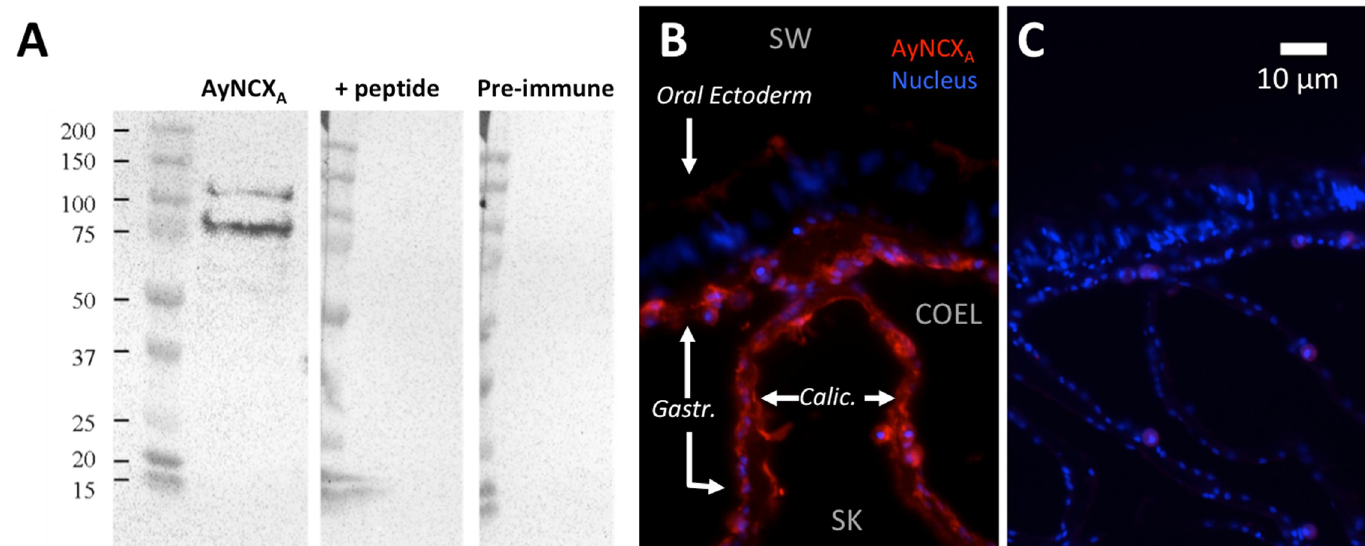
Fig 3. Validation of antibodies against AyNCXA. A) The anti-AyNCX A antibodies recognize a ~100 kDa and ~75 kDa protein in homogenized A . yongei tissue. Both bands are eliminated when the antibody is pre-absorbed with the epitope peptide overnight, and neither band is present when the membrane is incubated with the pre- immune serum. All sample wells contain the same amount of protein and all three Western Blot images were taken at the same exposure. B) Immunofluorescence microscopy of A . yongei tissue reveals AyNCX A is present in all four tissue layers, including the calicodermis. C) Pre-absorption of antibodies with antigen peptide eliminates signal at the same exposure, confirming antibody